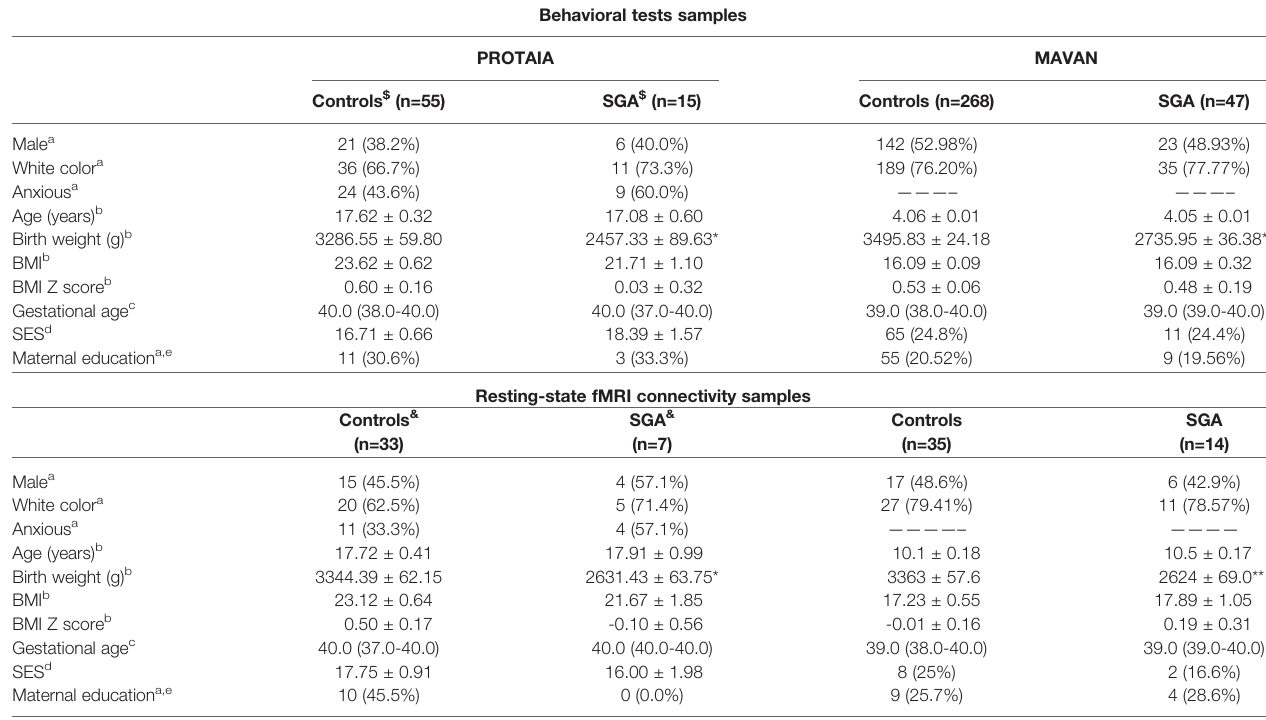
TABLE 1 | Participants ’ characteristics, according to the birth weight for gestational age groups (SGA vs. controls). Behavioral tests